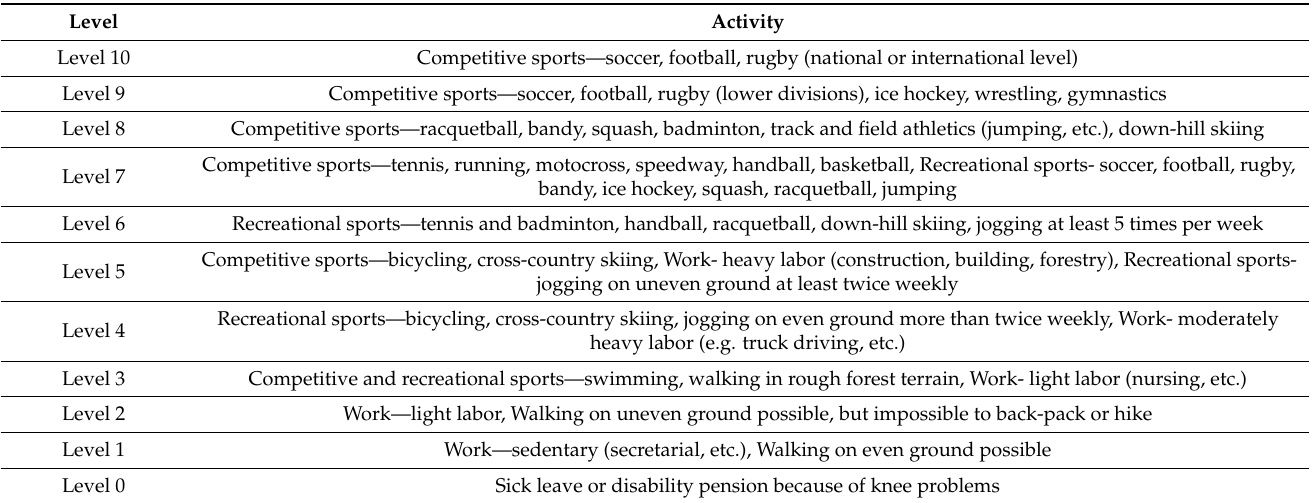
Table 1. The Tegner activity level